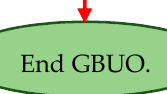
Figure 1. Flowchart of “the good, the bad, and the ugly” optimizer (GBUO).